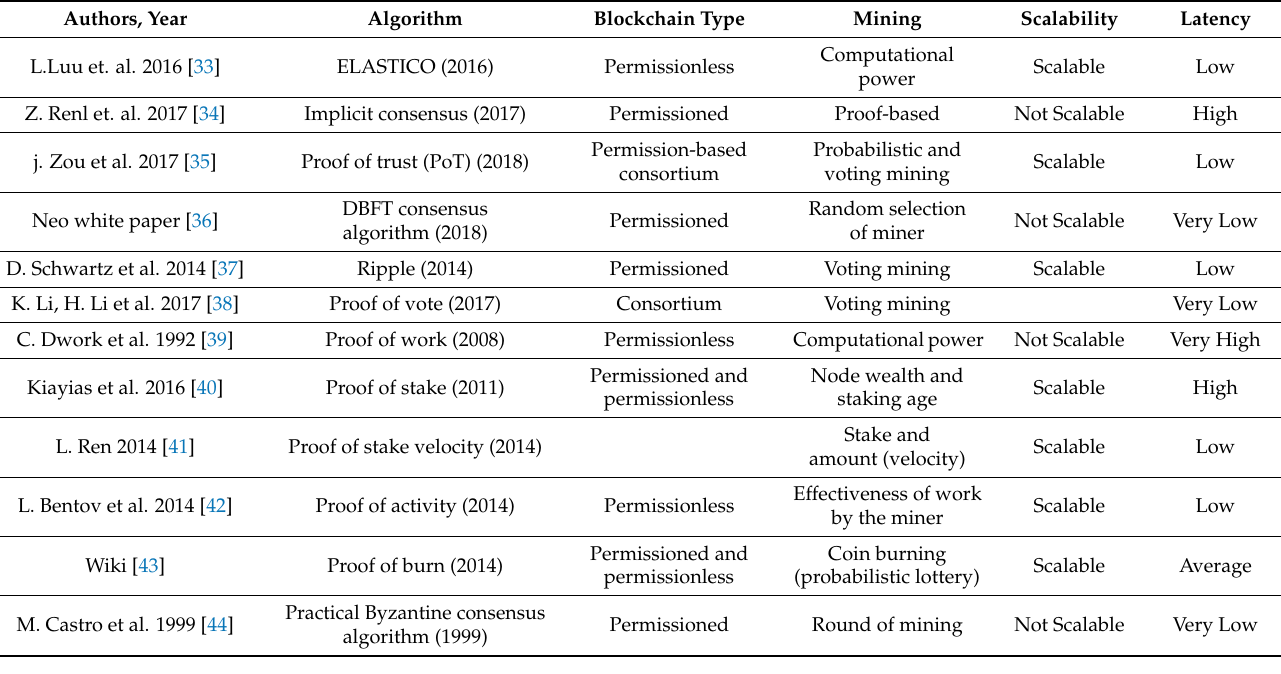
Table 1. Comparison of the consensus algorithms with respect to generic parameters.